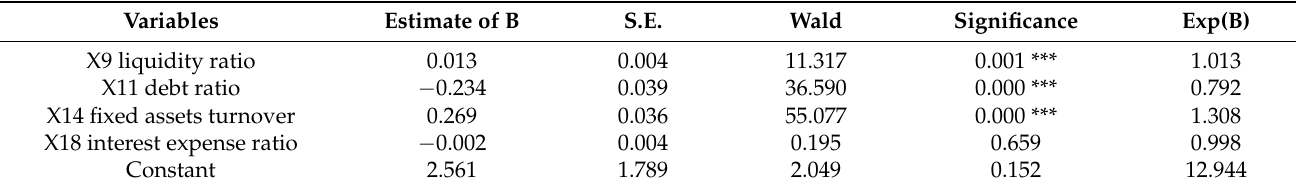
Table 16. Parameter values of feature selection variables of 982 normal and 491 bankrupt companies (2:1) in LR.